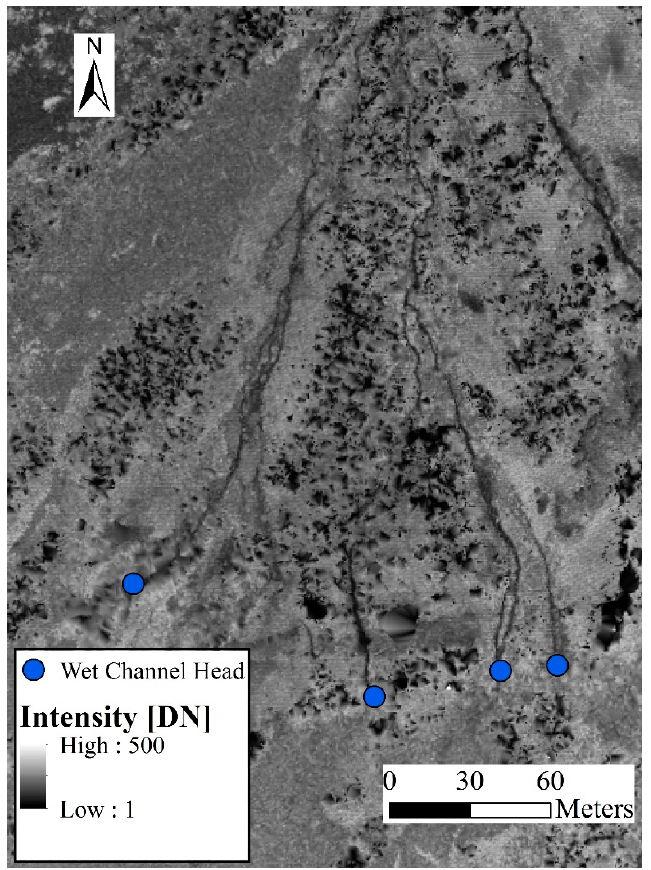
Figure 2. Intensity image during 2012 LiDAR survey for a headwater area in the Ward Creek watershed. The blue dots visually identified the wet channel head [DN: digital number] .